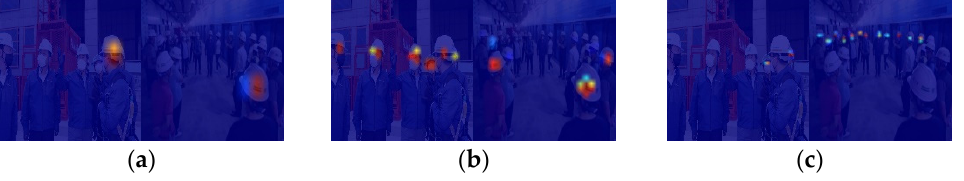
Figure 11. The visualized heat maps were generated by adding different attention mechanisms, as in Table 3. The visualization results are compared for each of the three different size feature maps obtained by MSFFN ( a ) 13 × 13, ( b ) 26 × 26, and ( c ) 52 × 52.